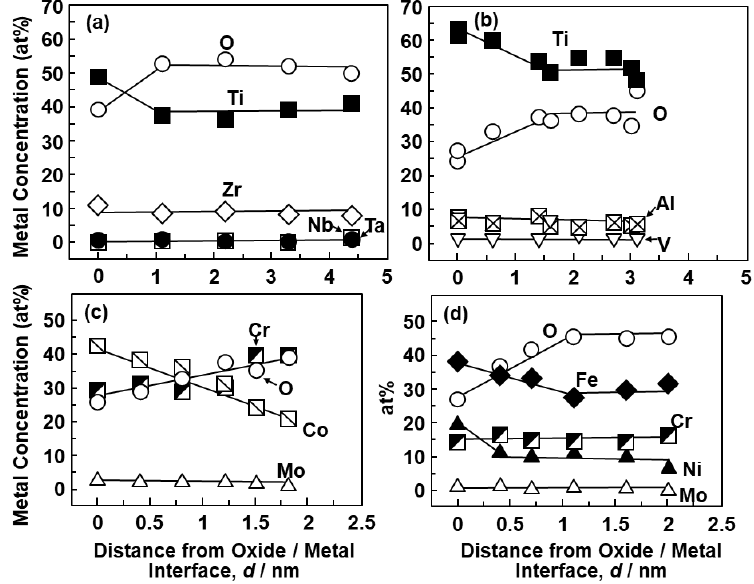
Figure 5. Changes in metal concentrations (at%) in oxide films formed on ( a ) Ti–15Zr–4Nb–1Ta, ( b ) Ti–6Al–4V, ( c ) Co–28Cr–6Mo, and ( d ) high-N stainless steel from oxide / metal interface to oxide film surface.